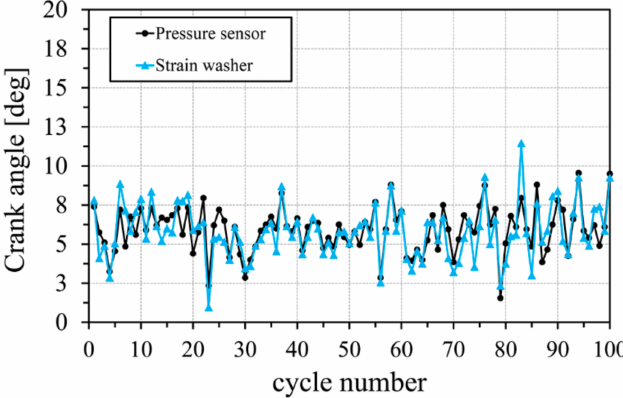
Figure 15. MBF50 evaluated by the pressure sensor and the strain washer at 4500 rpm and full throttle on 100 consecutive